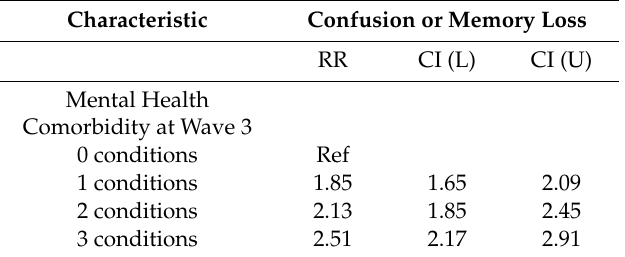
Table 2. The association of confusion or memory loss (CML) with mental health comorbidity for the full sample 1,2 .